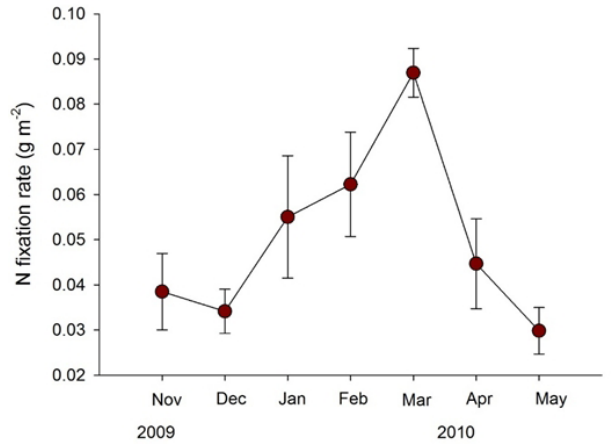
Figure 8. Daily rates of N fixation based on ARA over 7 months; error bars represent standard error of the mean